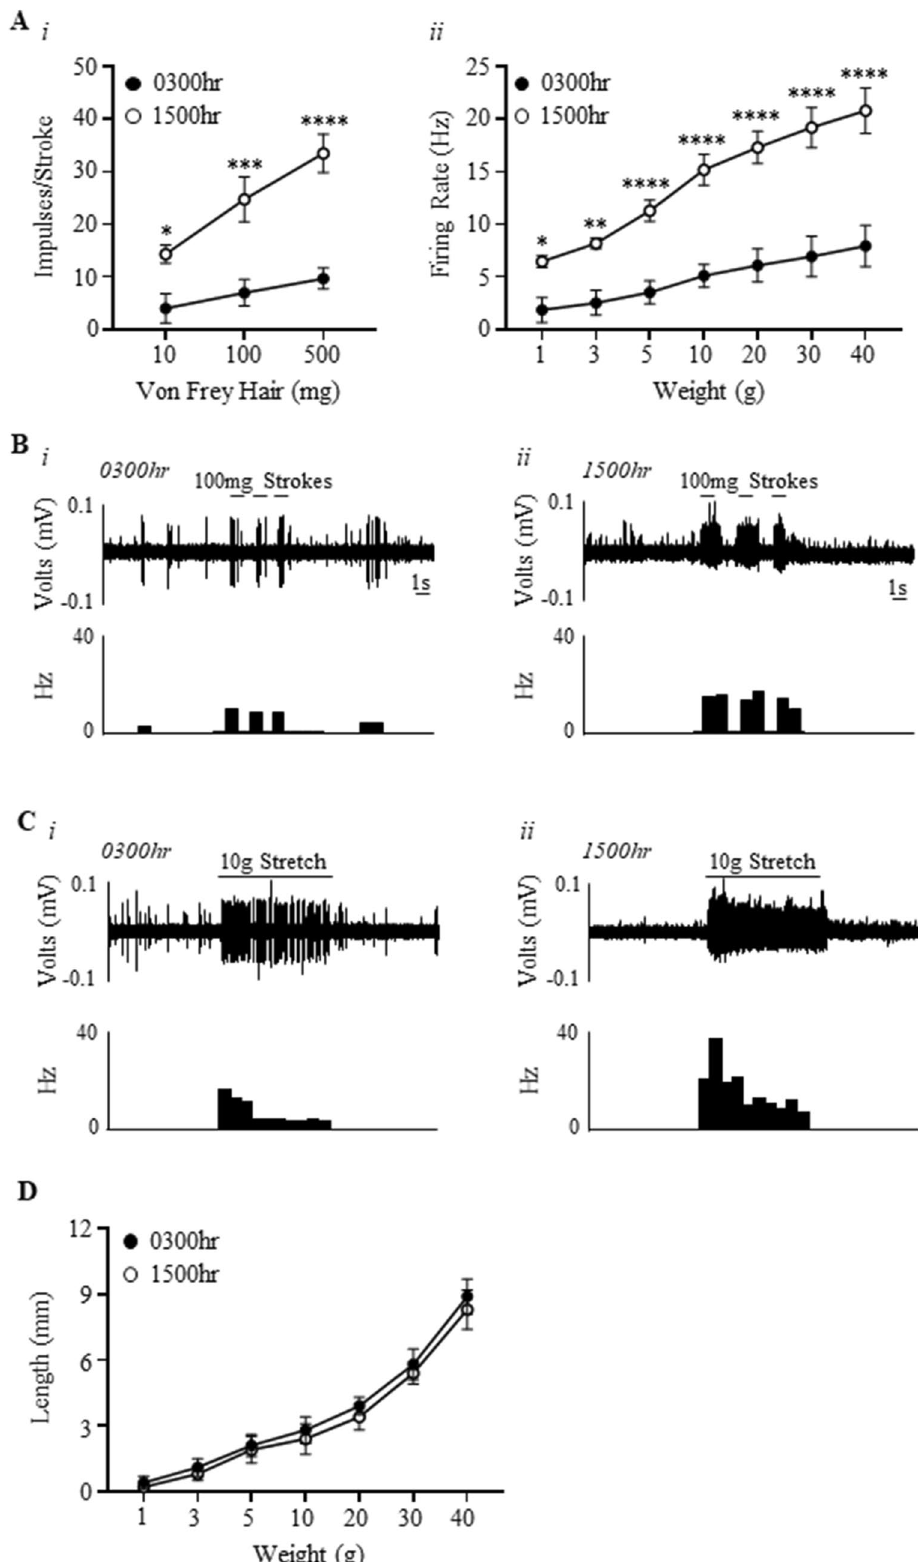
Figure 2. Bladder low-threshold muscular-mucosal afferents are more mechano-sensitive during the day compared to the night. ( A ) The response of low-threshold muscular-mucosal afferents to ( i ) mucosal stroking (10, 100, and 500 mg) and ( ii ) stretch (1–40 g) at 0300 h and 1500 h. N = 6, n = 12 at each time point. *P < 0.05, **P < 0.01, ***P < 0.001, ****P < 0.0001. ( B ) An example of a raw trace of muscular-mucosal afferent responses to 100 mg stroking at 0300 h and 1500 h. ( C ) An example of a raw trace of muscular-mucosal afferent responses to 10 g stretch at 0300 h and 1500 h. ( D ) Bladder compliance determined by measuring length of the bladder preparations during imposed stretch (1–40 g) at 0300 h and 1500